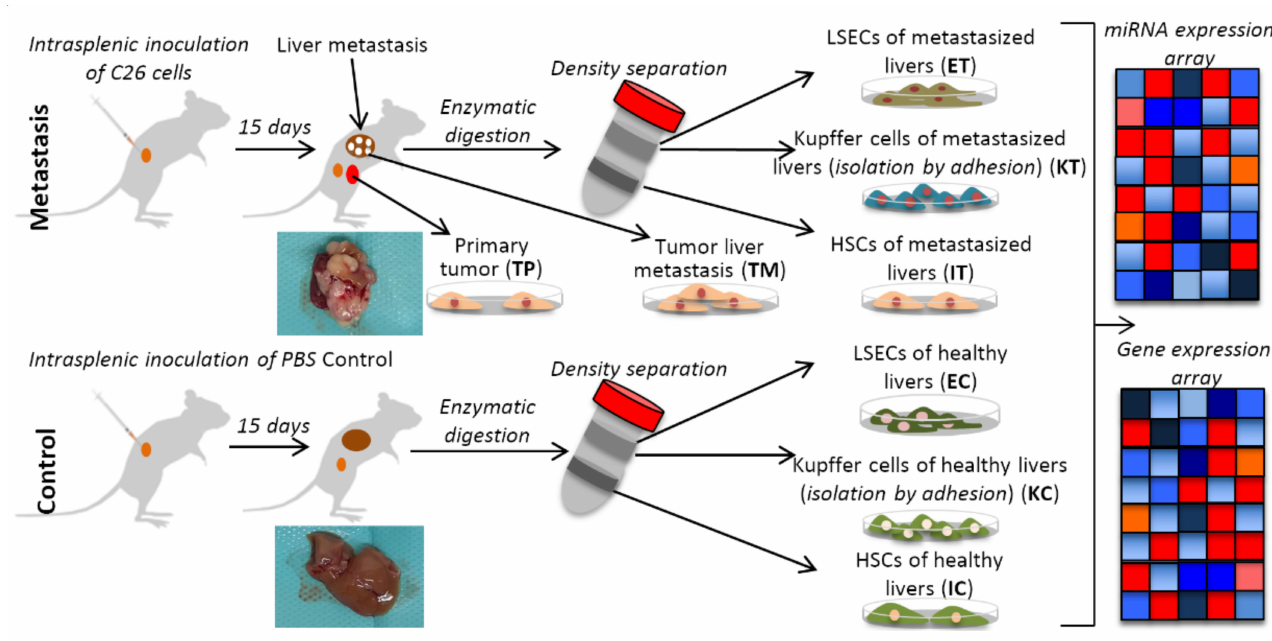
Figure 1. Schematic representation of the experimental design with the murine liver metastasis model. Two groups of mice were inoculated, one with C26 murine colon cancer cells (Tumor) and another with PBS (Control), respectively. After 15 days, the mice were perfused and after Percoll gradient centrifugation, three types of liver cells were collected, namely, liver sinusoidal endothelial cells (E), Ito cells (I) and Kupffer cells (K) from the healthy control (C) and the tumor microenvironment, TME (T), and isolated to perform omics experiments (gene expression and miRNA expression microarrays). TP and TM denote colorectal cancer (CRC) primary and tumor liver metastasis cells, respectively. Insert images of metastasized and healthy livers harvested in our experiments are shown for each